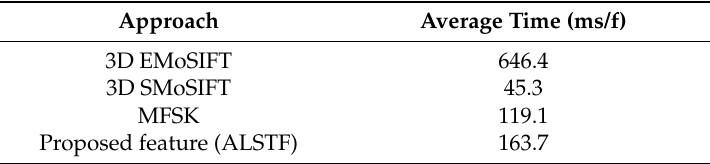
Table 6. The computational efficiency of 3D EMoSIFT, 3D SMoSIFT, MFSK and the proposed feature.